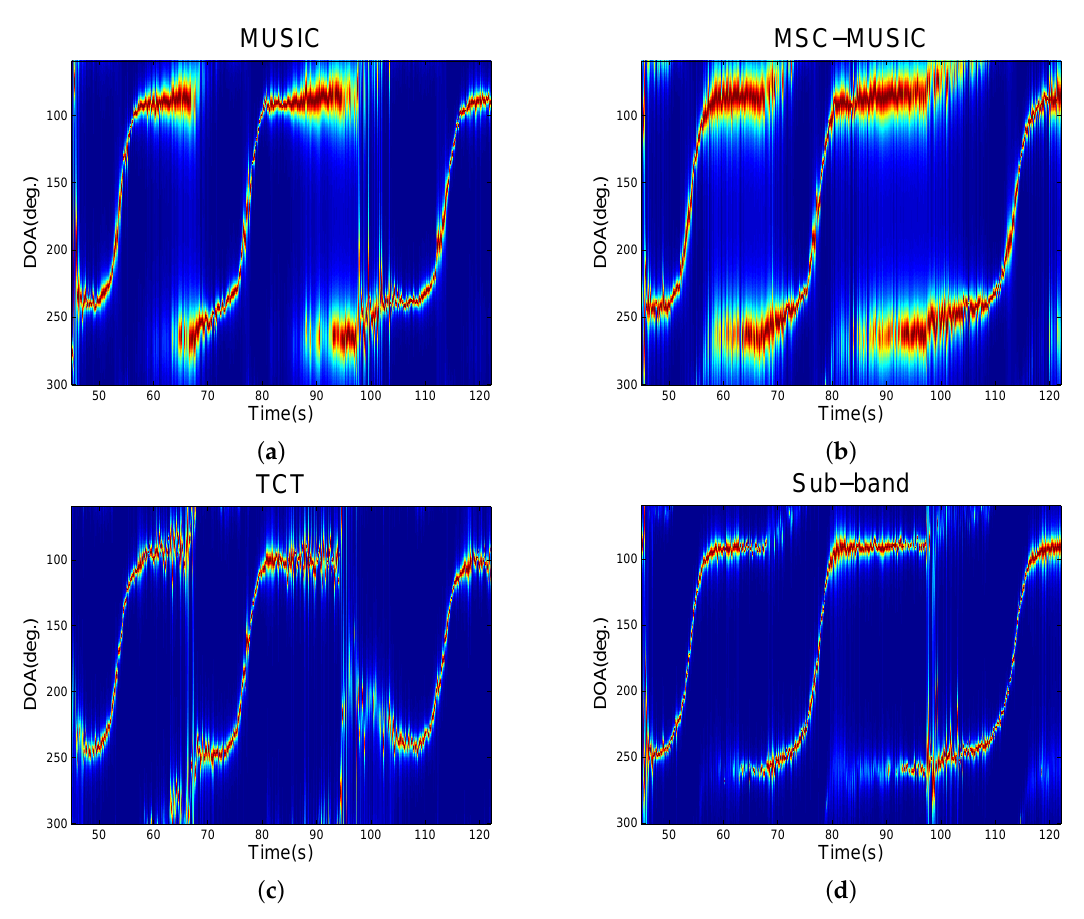
Figure 11. Multiple vehicles tracking. ( a ) is from the MUSIC; ( b ) is from the MSC-MUSIC; ( c ) is from the TCT; ( d ) is from the proposed sub-band